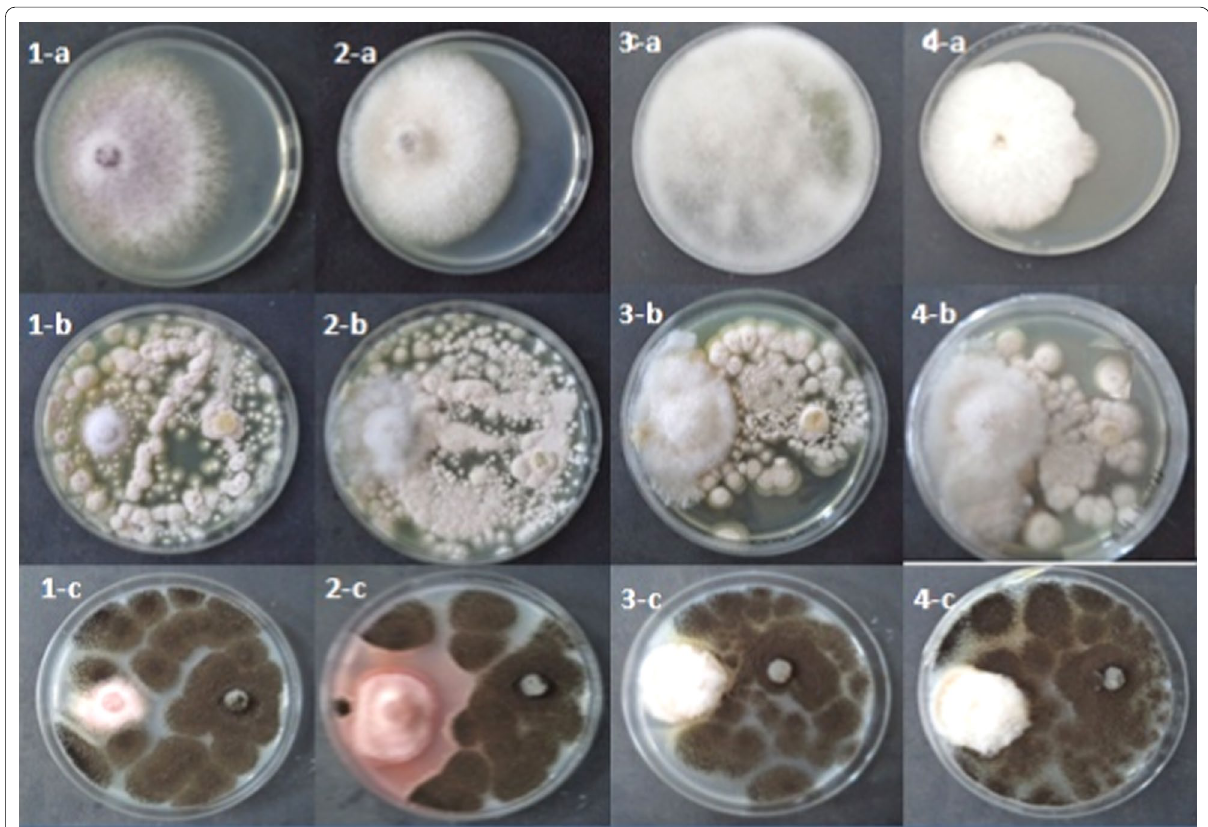
Fig. 1 Comparisons between colonies of Fusarium oxysporum (1), F. solani (2), Pythium ultimum (3) and Phytophthora citrophthora (4) controls ( a ) and these pathogens confronted with Aspergillus candidus A5 ( b ) and A. niger A10 ( c ) after 6 days of incubation at 25 °C